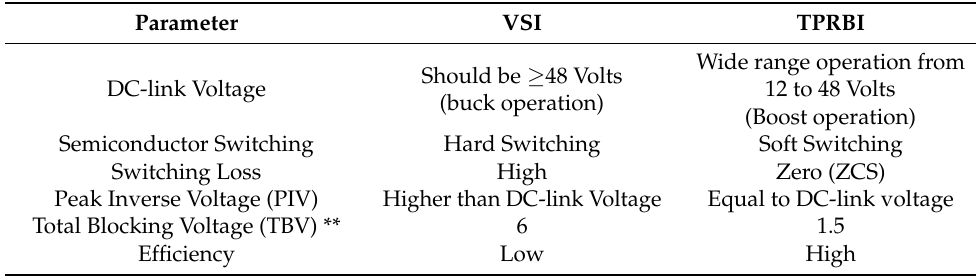
Table 3. Comparative